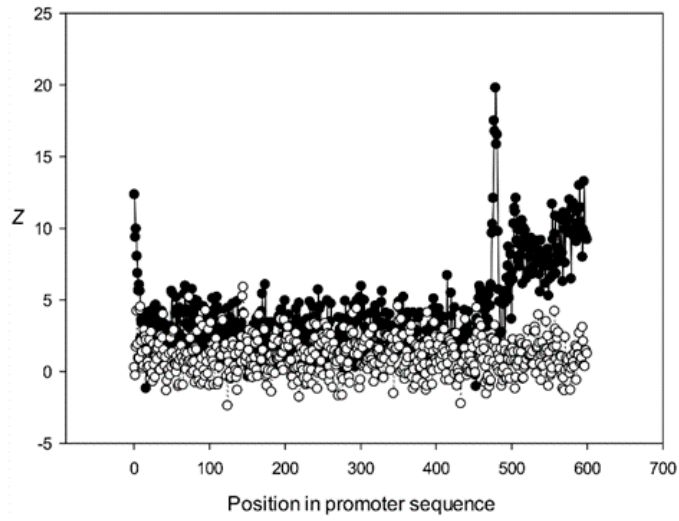
Figure 11. Dependence of Z on position l for promoter sequences of the third class. Black circles indicate multiple alignment for promoter sequences of the third class and white circles indicate randomly mixed promoter sequences where positions of indels were maintained.